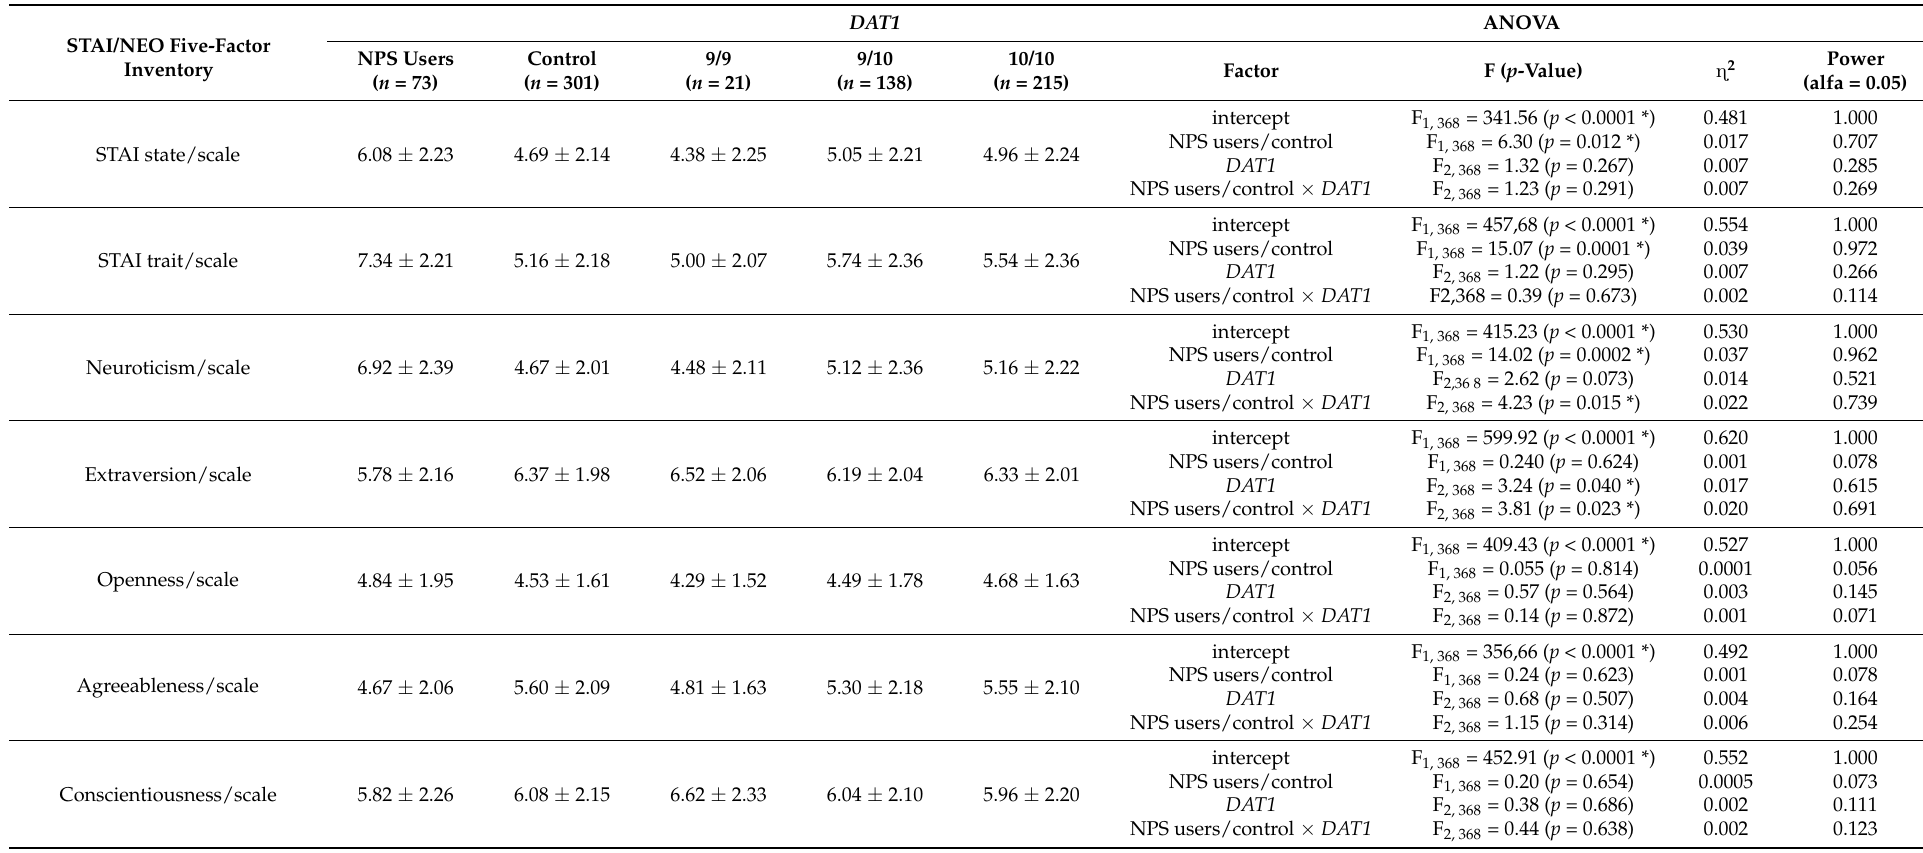
Table 4. Differences in DAT1 and the NEO Five-Factor Inventory scale or the STAI scale, between healthy control subjects and NPS